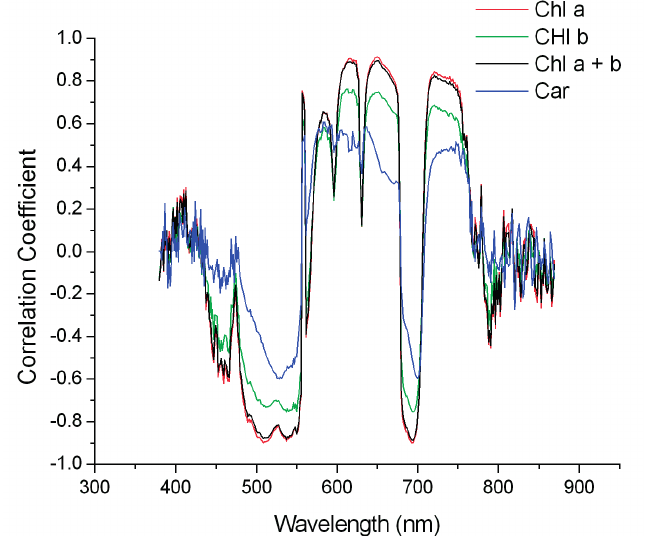
Figure 7. Correlogram of the mean derivative spectral reflectance versus pigment